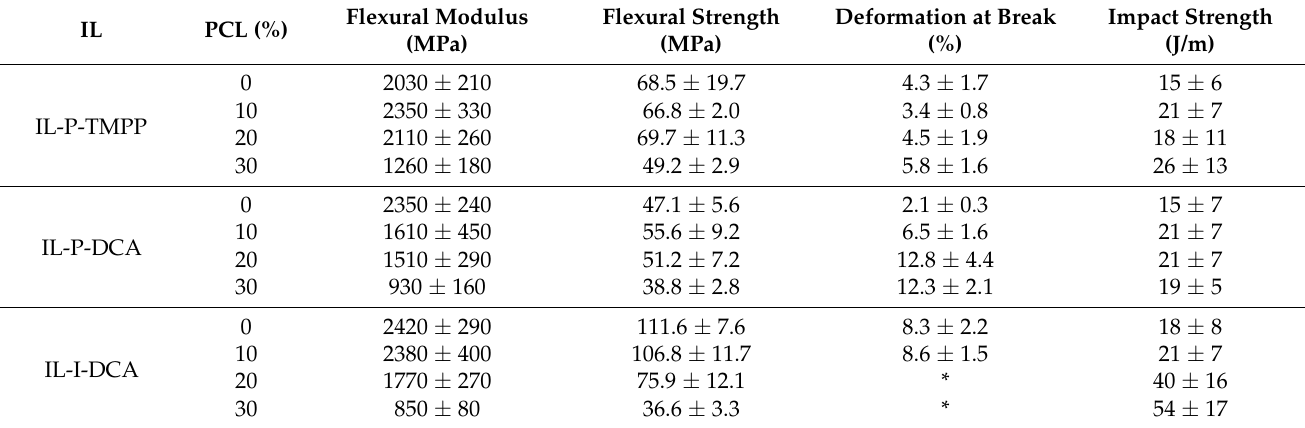
Table 5. Mechanical properties of the IL-cured epoxy/PCL